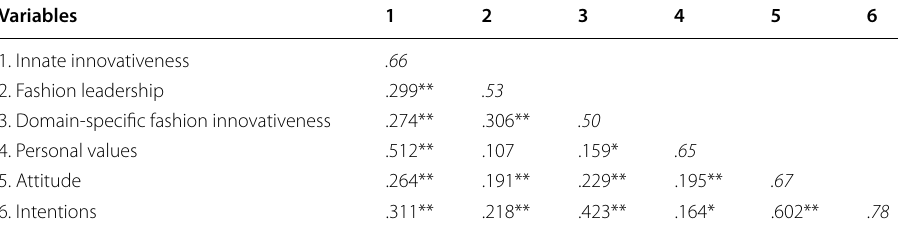
Average variance extracted (AVE) is shown on the diagonal * p .05; ** p ≤ ≤